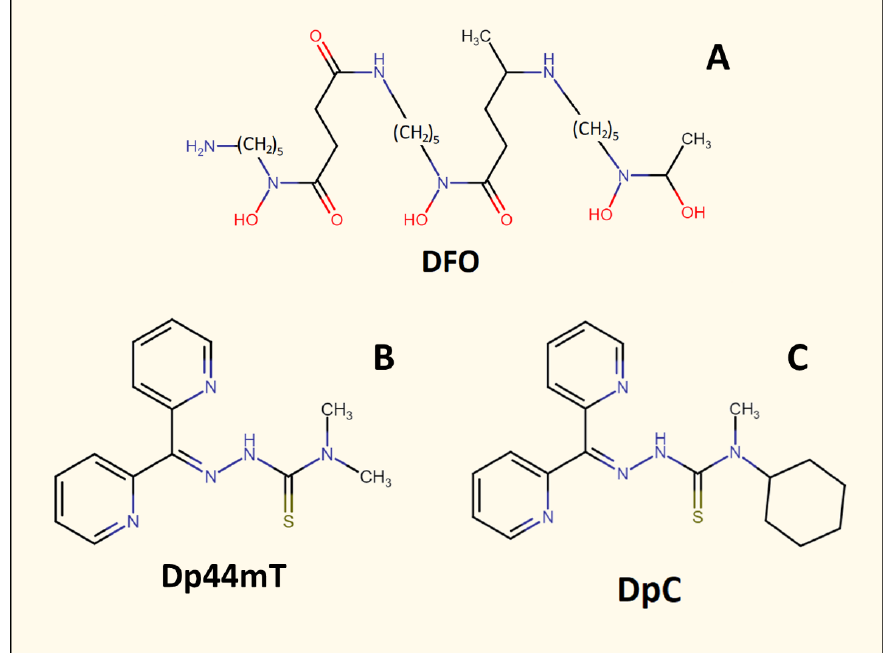
Figure 4. Line drawings of the chemical structures of the metal-binding ligands described herein: ( A ) desferrioxamine (DFO), ( B ) di-2-pyridylketone 4,4-dimethyl-3-thiosemicarbazone (Dp44mT), and ( C ) di-2-pyridylketone 4-cyclohexyl-4-methyl-3-thiosemicarbazone (DpC).